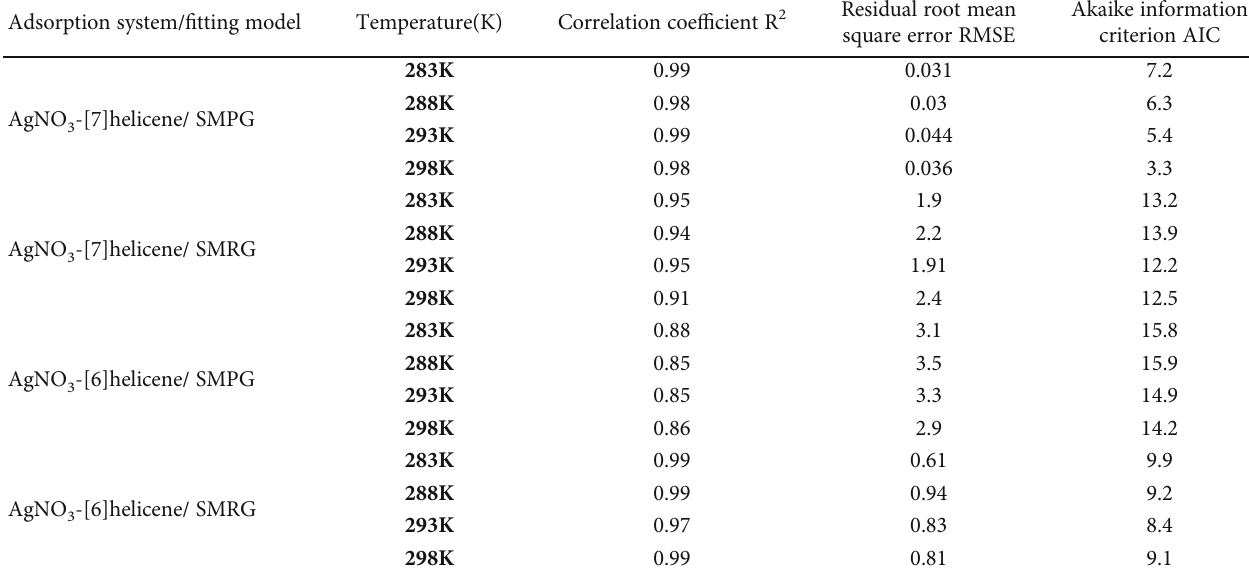
Table 1: Values of the Correlation coe ffi cient R 2 , the Residual root mean square error coe ffi cient RMSE and the Akaike information criterion AIC deduced from fi tting the experimental adsorption isotherms of silver nitrate on helicenes with the two single-layer adsorption models (SMPG and